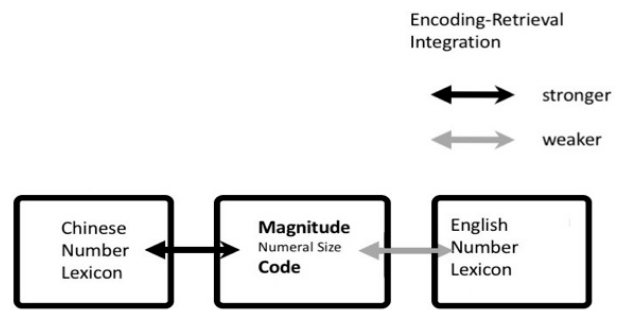
Figure 1. Illustration of a simplification of the Encoding-Complex hypothesis by Chinese-English bilinguals (Campbell and Epp 2004). The arrows have two different colors, according to the strength of the integrations. Grey arrows illustrate weak integration of the interfacing processing, black arrows represent strong integration. Therefore, the Chinese Number Lexicon (acquired at school) has a stronger connection to the Magnitude code than the English Number Lexicon.